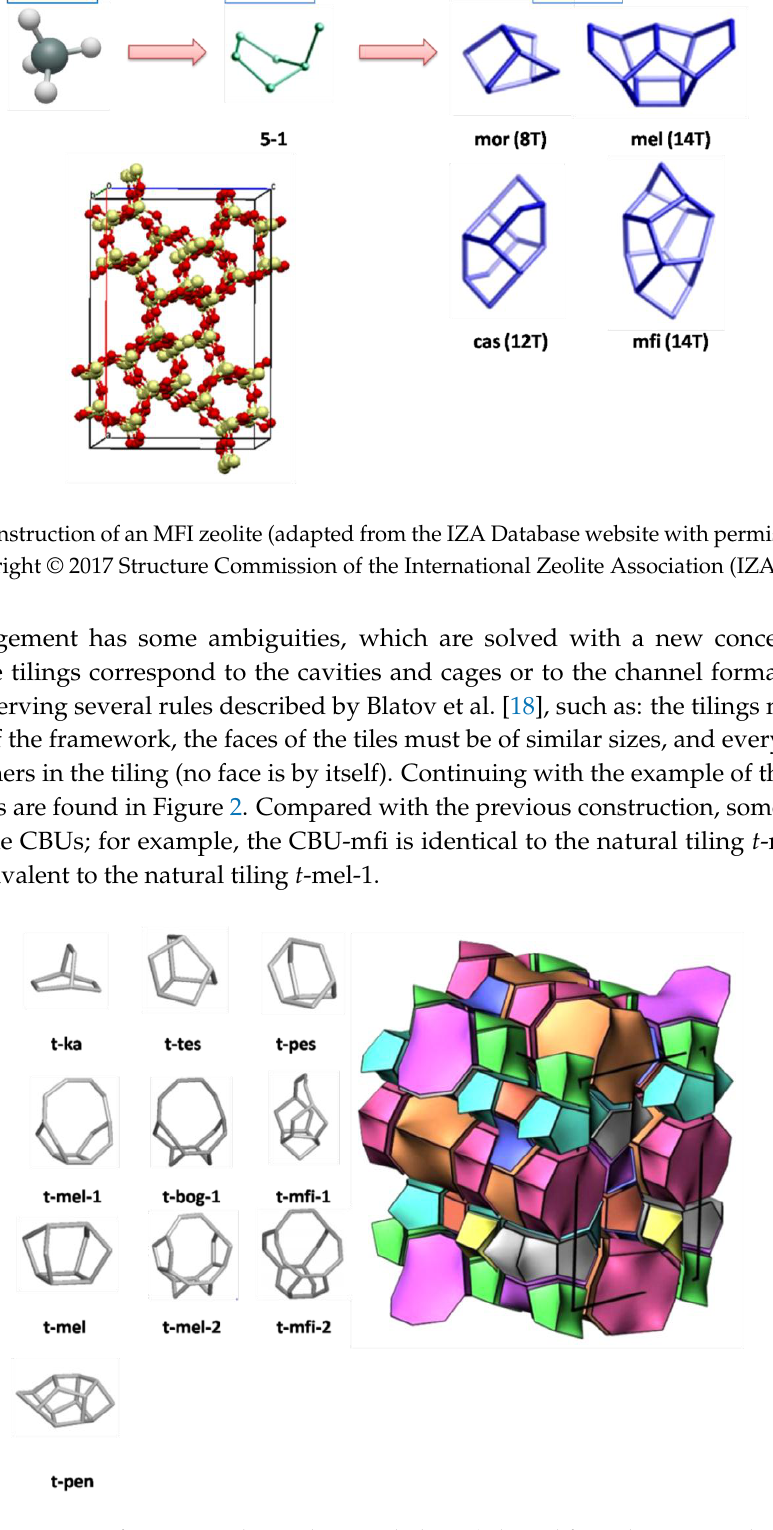
Figure 2. Construction of an MFI zeolite with natural tilings (adapted from the IZA Database website with permission from ref. 12, copyright © 2017 Structure Commission of the International Zeolite Association (IZA-SC) [12] and adapted from ref. 17, copyright © 2010 American Chemical Society [17]).